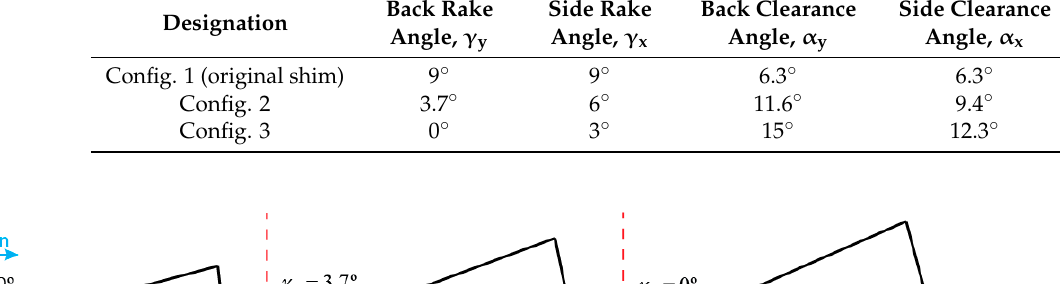
Table 2. Cutting tool angles according to the machine reference system.